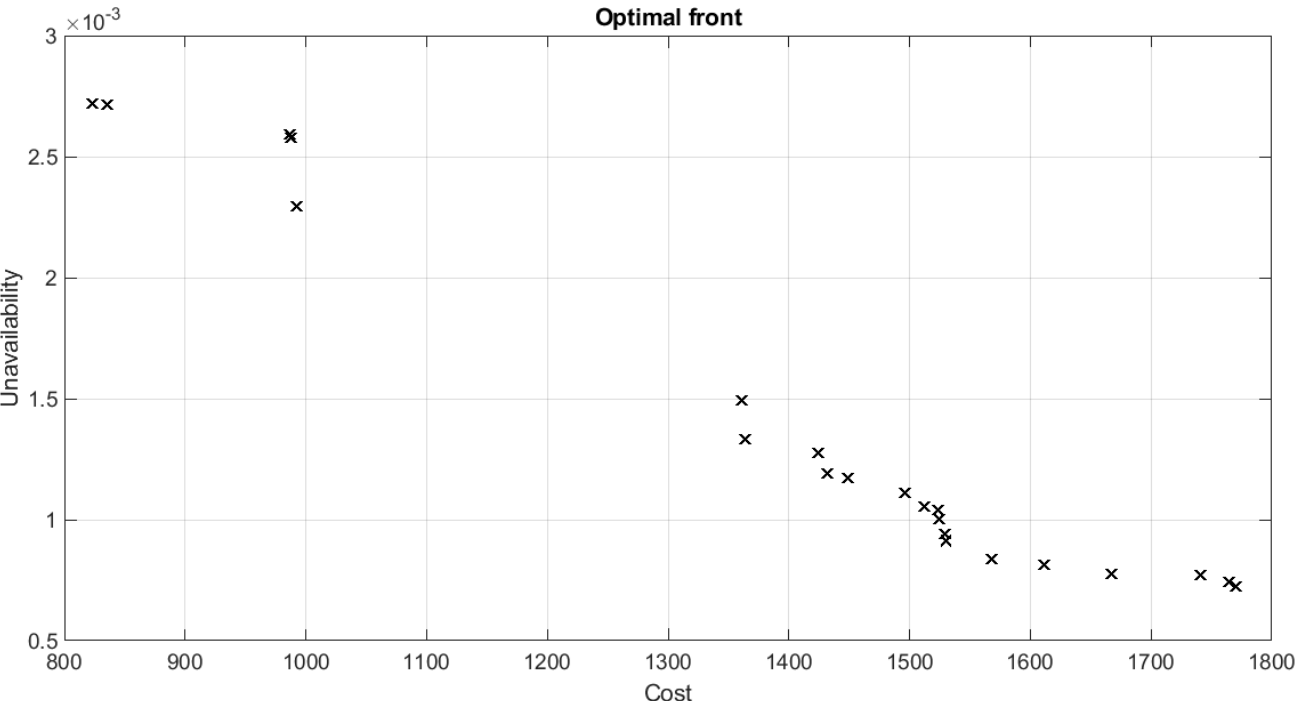
Figure 6. Non-dominated